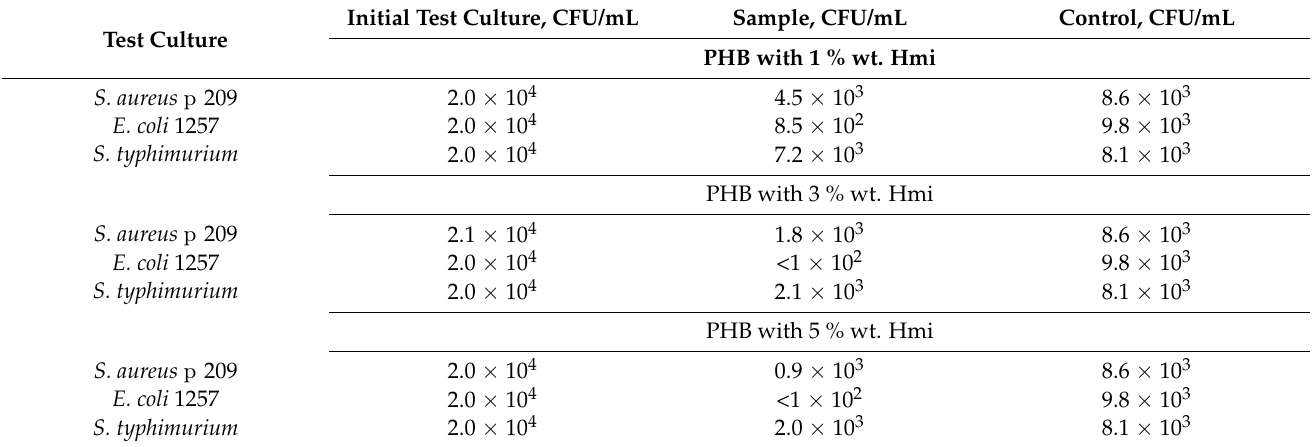
Table 5. Antimicrobial activity of electrospun fibrous materials based on PHB–Hmi composites. Test